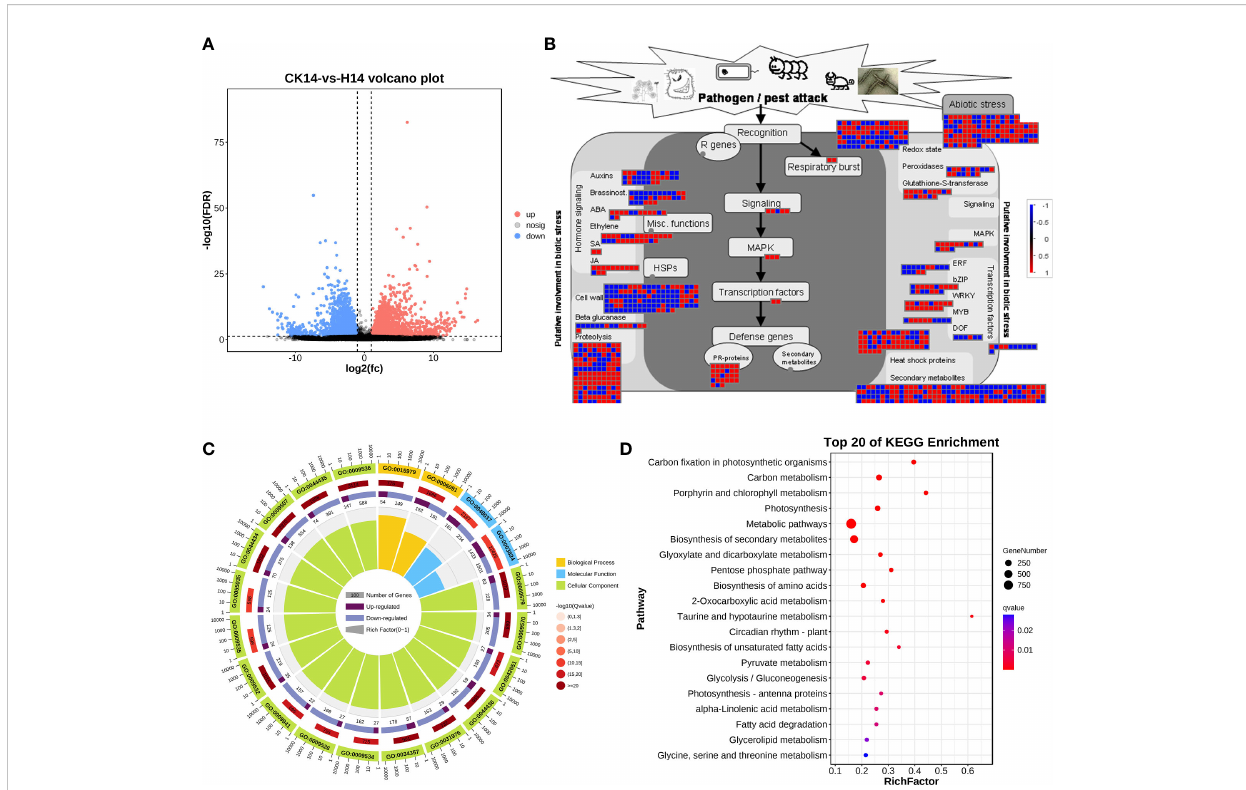
FIGURE 4 Transcription variations in Nicotiana benthamiana at 14 days post inoculation of the H virus. (A) Differentially expressed transcripts in N. benthamiana at 14 dpi of the H virus. (B) Visualization of changes in the expression of genes relevant to the biotic stress of N. benthamiana challenged with the H virus. The scale bar represents fold-change values in the CK14 vs. H14 comparison. (C) GO analysis of the DEGs in N. benthamiana induced by the stress of H virus at 14 dpi. The terms molecular function, biological process, and cellular component are shown. (D) KEGG analysis of the DEGs of N. benthamiana in the CK14 vs. H14 comparison. The top 20 KEGG enrichment pathways for DEGs are presented. DEGs, differentially expressed genes; dpi, days post inoculation; GO, gene ontology; KEGG, Kyoto Encyclopedia of Genes and Genomes; H, Hippeastrum chlorotic ringspot